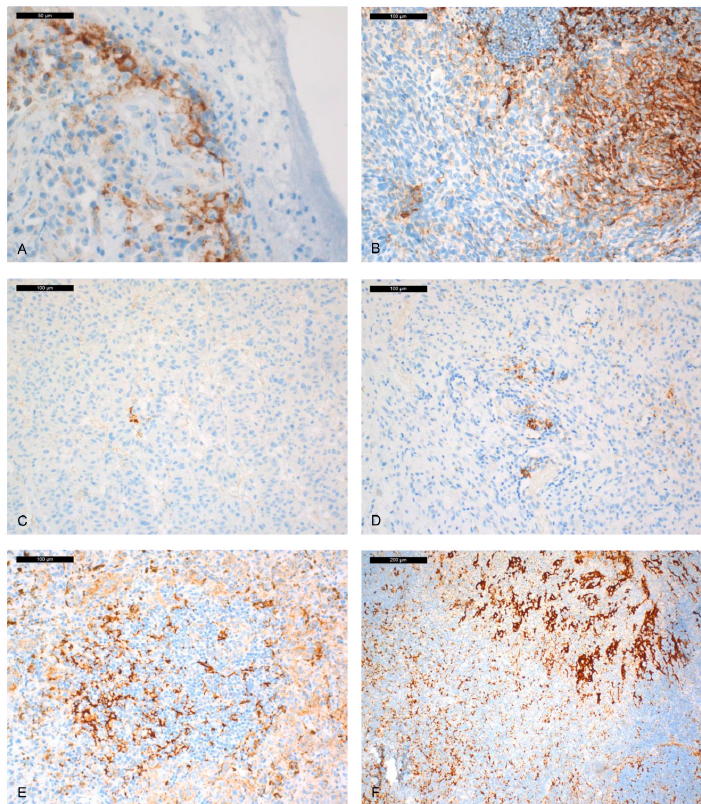
Figure 2. PD-L1 expression in tumour and immune cells with the SP263 clone (the panels with different percentages of PD-L1 expression in TC and IC are representative of images showing similar results). ( A ) staining of very few tumour cells (TC) (3% of all tumour cells). ( B ) focal TC staining (15% of all TC). ( C ) rare immune cell (IC) staining (1%). ( D ) focal IC staining (5%). ( E ) moderate IC staining (20%). ( F ) Positive control (immuno-peroxidase; A : ×400; B – E : ×200; F : ×100). Table 1. PD-L1 TC and IC staining with the 2 PD-L1 antibodies.